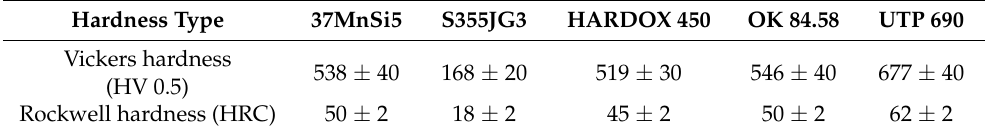
Table 5. Measured hardness values.